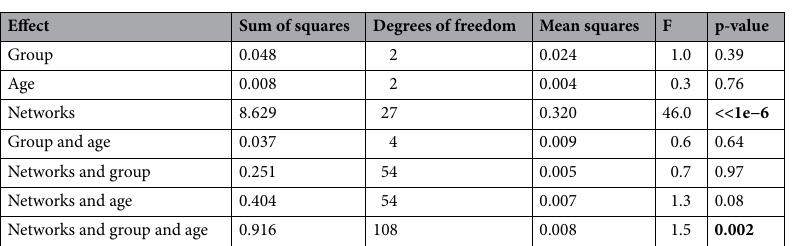
Table 2. Repeated measures ANOVA for the effects of group, age, functional network pair and their interactions. Significant values are given in bold.